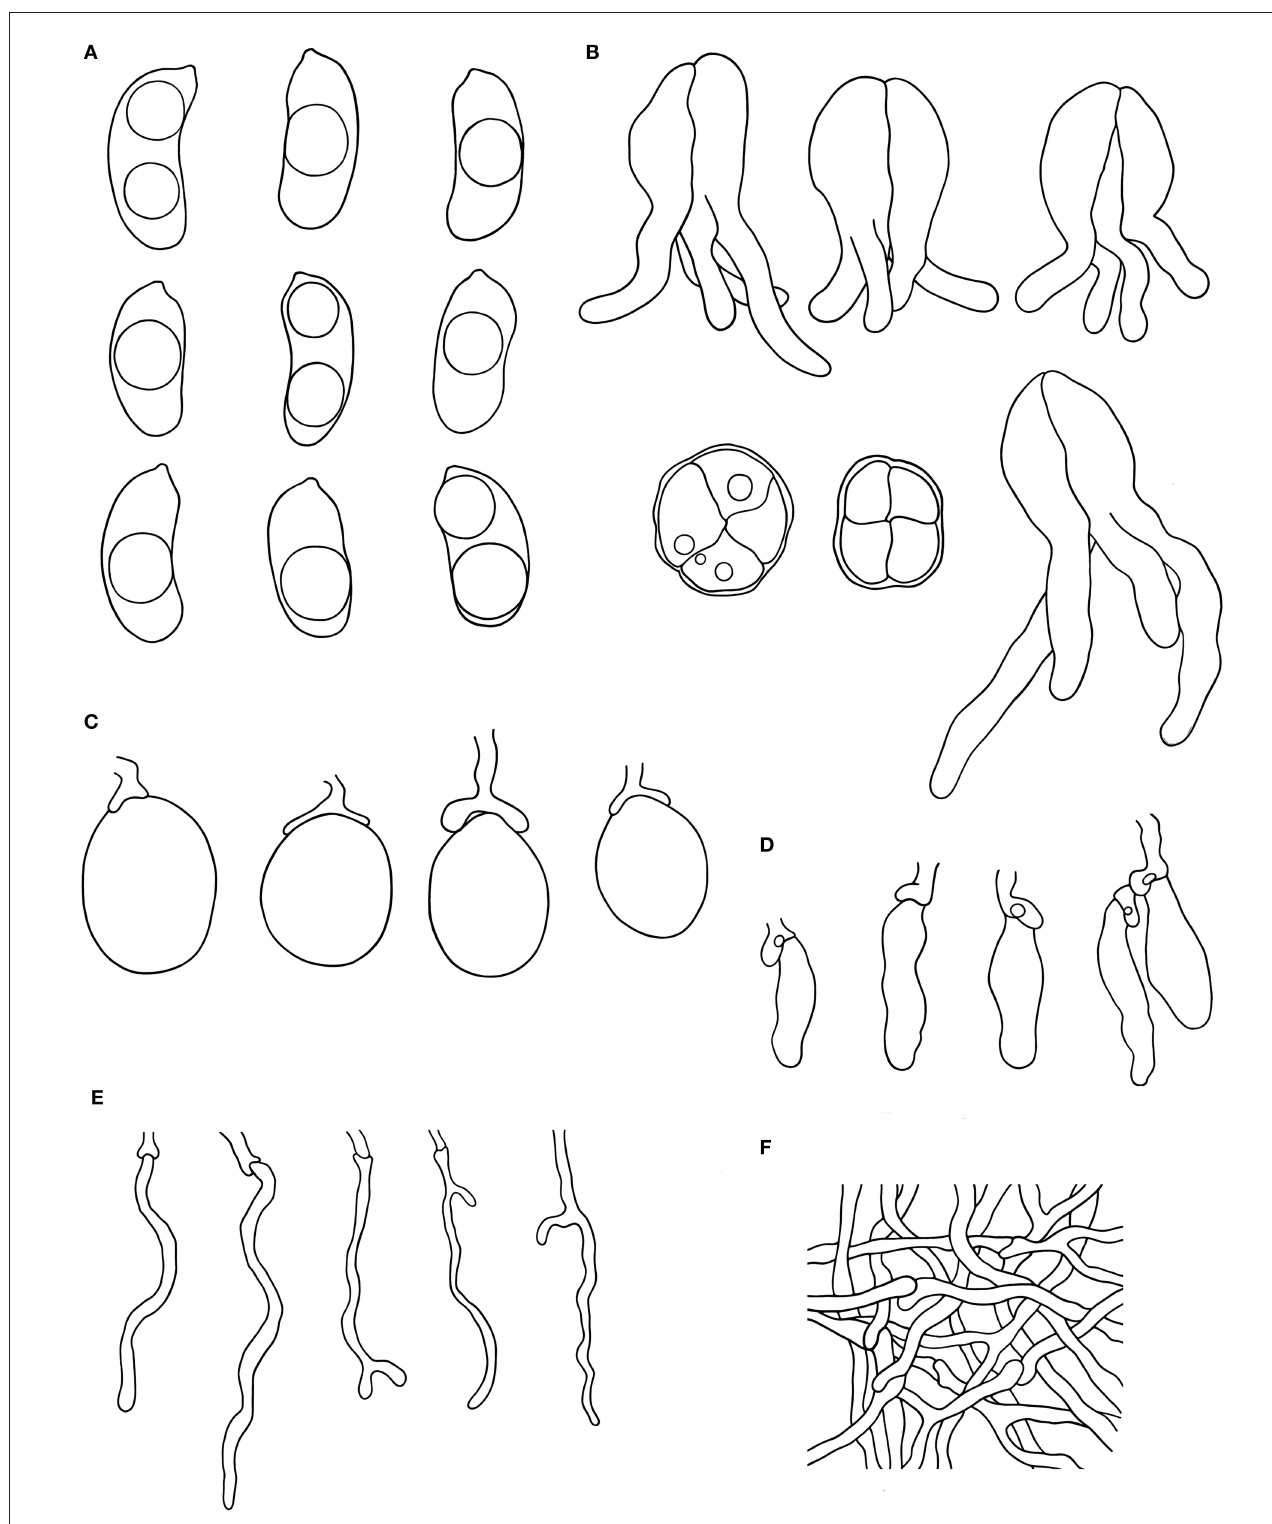
FIGURE 3 | Microscopic structures of Alloexidiopsis australiensis (drawn from the holotype). (A) Basidiospores. (B) Basidia. (C) Basidioles. (D) Cystidia. (E) Hyphidia. (F) Hyphae from subiculum. Scale bars = 10 µ m.